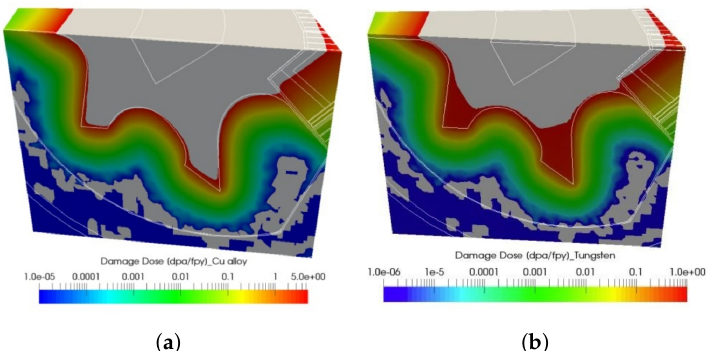
Figure 25. Simulation of irradiation damage in the divertor for ( a ) Cu alloy and ( b ) W. Reprinted with permission from Ref. [131]. Credit c (cid:13) IOP Science, 2017.